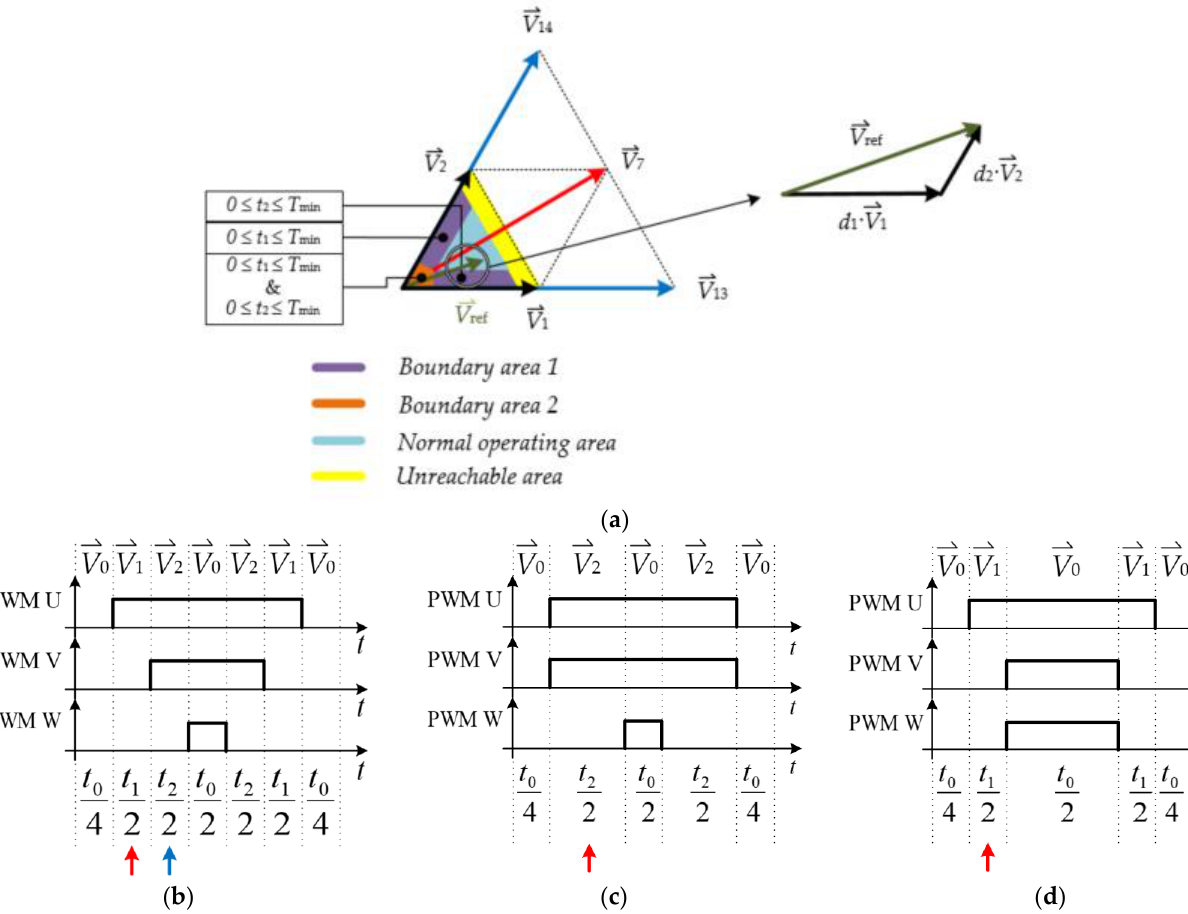
Figure 7. ( a ) Vector diagram for Sector 1 and Region 1 with marked problematic areas for single-shunt measurement; ( b ) SVM pattern for Sector 1 and Region 1 inside the normal operating area; ( c ) SVM pattern while t 1 = 0 s; ( d ) SVM pattern while t 2 = 0 s.